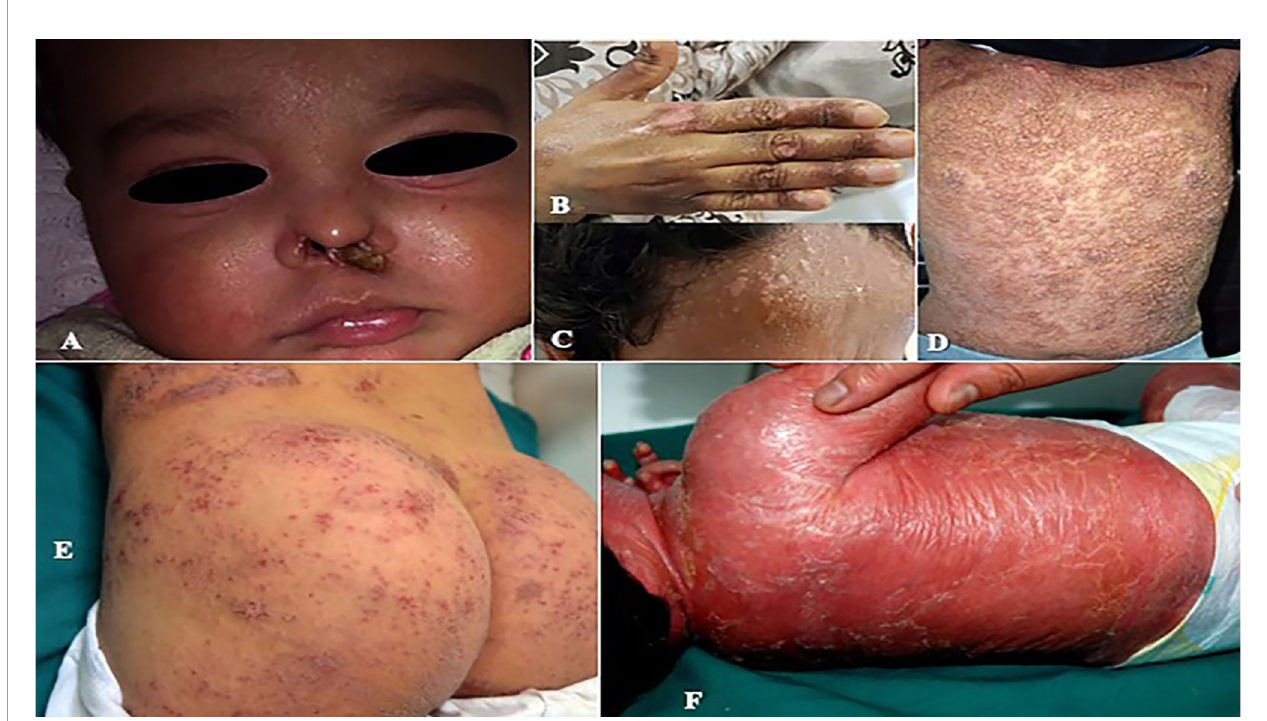
FIGURE 1 | (A) Perinasal ecthyma gangrenosum in a patient with DCLRE1C de fi ciency. (B, C) Multiple recalcitrant warts in a patient with common variable immunode fi ciency (CVID). (D) Generalized molluscum contagiosum in a patient with dedicator of cytokinesis 8 ( DOCK8 ) de fi ciency. (E) Severe eczematous rashes in a patient with signal transducer and activator of transcription 3 ( STAT3 ) de fi ciency. (F) Erythroderma in a patient with Omenn syndrome due to recombination activation gene 1 ( RAG1 ) de fi